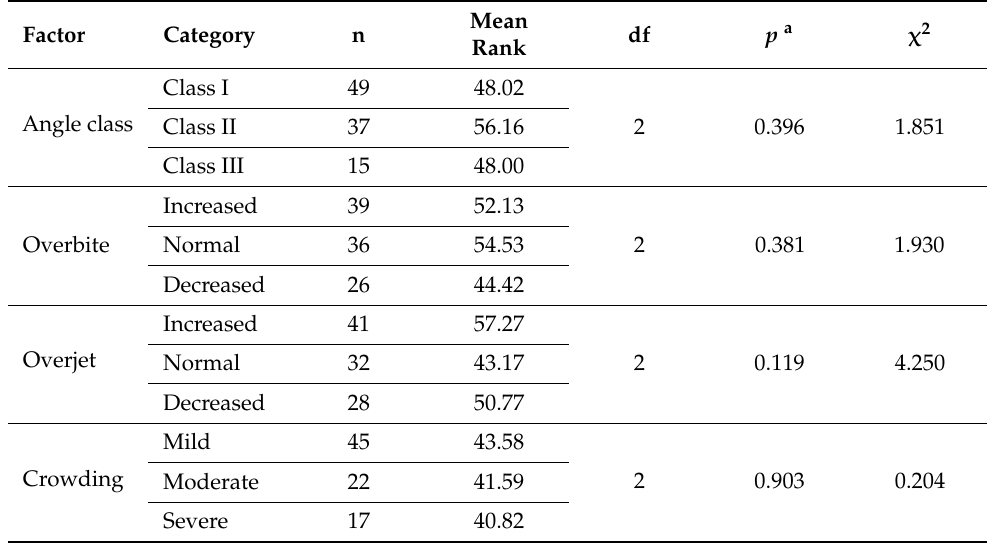
Table 4. Summary statistics of the non-normally distributed outcome number of failed brackets for different variables.